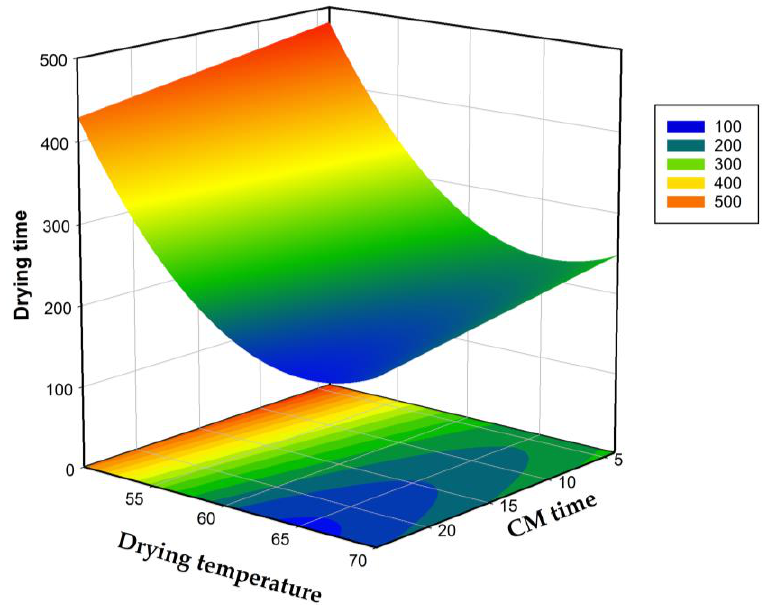
Figure 1. Influence of drying temperature (°C) and CM time (h) on drying time (min) of dried straw- berries with CM pre-treatment.